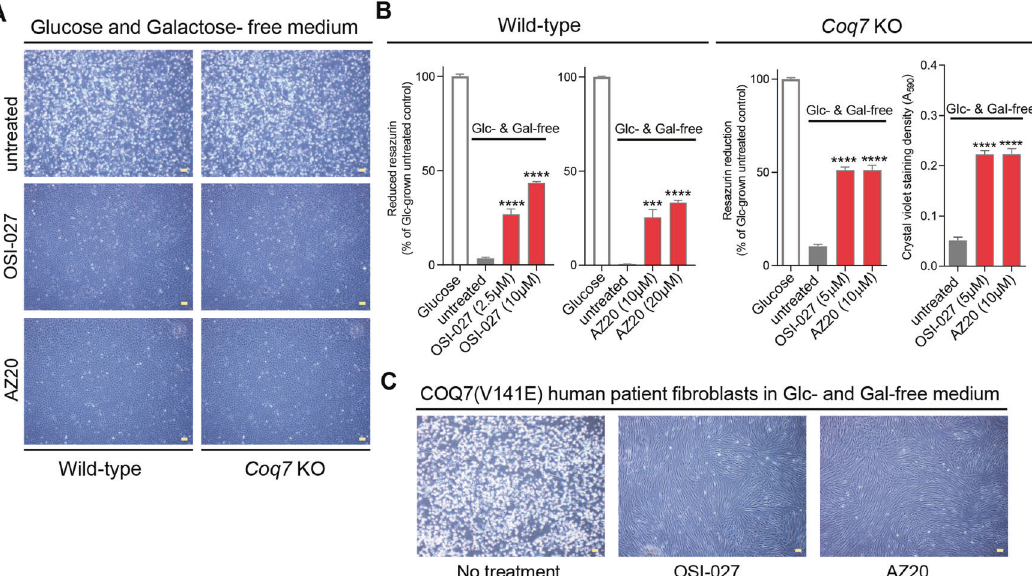
Fig. 2 Rescue of cell death in the absence of glucose and galactose. A , B Phase-contrast microscopy images and cell viability results. The results shown are after 2 days of culture in the medium lacking sugar sources (glucose and galactose). Glc: glucose, Gal: galactose. Means ± SEM are shown ( n = 4). *** p < 0.001, **** p < 0.0001, assessed by one-way ANOVA followed by Dunnett ’ s multiple comparison test versus untreated control in the same growth condition. C Microscopy images of patient skin fi broblasts carrying the COQ7(V141E) mutation. Pictures were taken after 2-day culture in glucose- and galactose-free medium. OSI-027, 5 µM. AZ20, 20 µM. Scale bars = 100